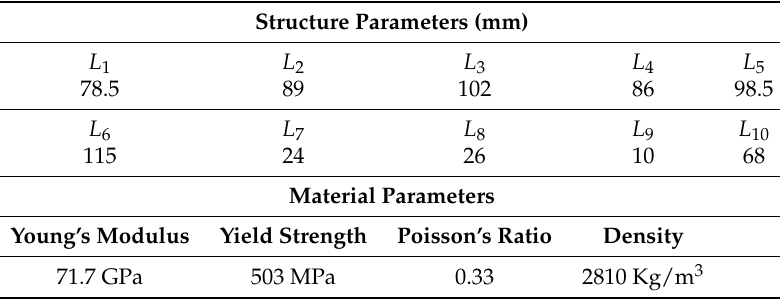
The main structure and material parameters of an XY decoupled compact parallel micromanipulator